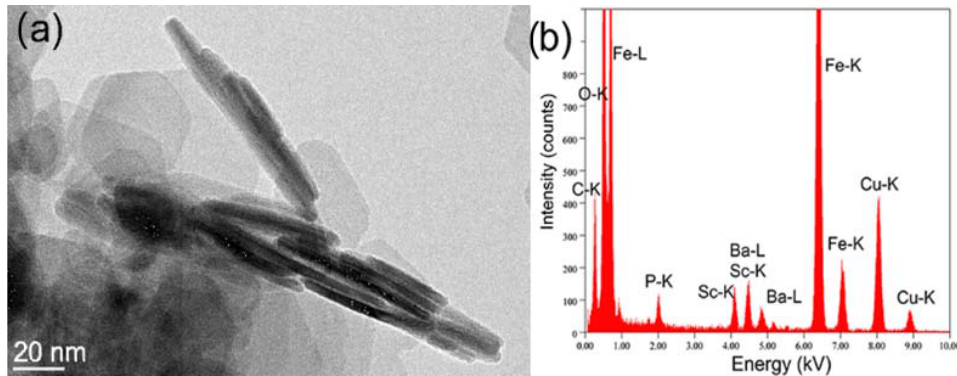
Figure 5. BSHF@AL-1.5-slow NPLs: ( a ) TEM image and ( b ) the corresponding EDXS spectrum. Arrows in panel ( a ) point to an amorphous surface layer on the NPLs perpendicular to the TEM grid. Cu and C in the EDXS spectrum ( b ) originate from the TEM grid, and C can also originate from AL.